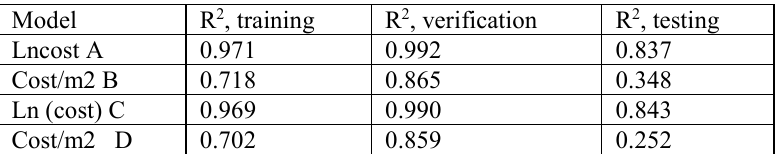
Table (1) Performance of Neural Network